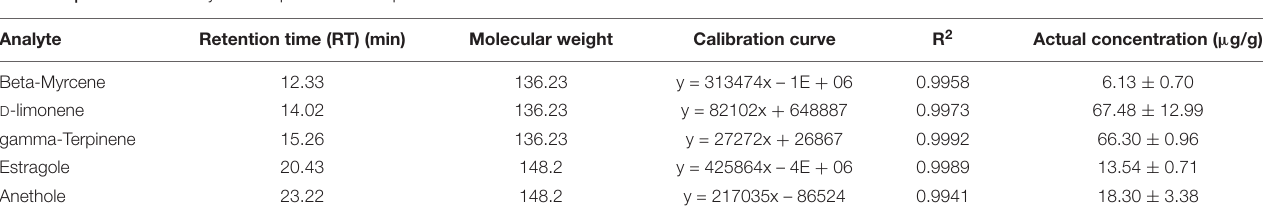
FIGURE 4 | Separation and characterization of terpene compounds from fennel root volatiles and fennel rhizosphere soil by gas chromatography (GC) mass spectrometry (MS) analysis. (A) GC–MS profiles of root volatiles, (B) GC–MS profiles of rhizosphere soil, and (C) GC–MS profiles of the control soil. TABLE 1 | Quantitative analysis of terpenes in rhizosphere